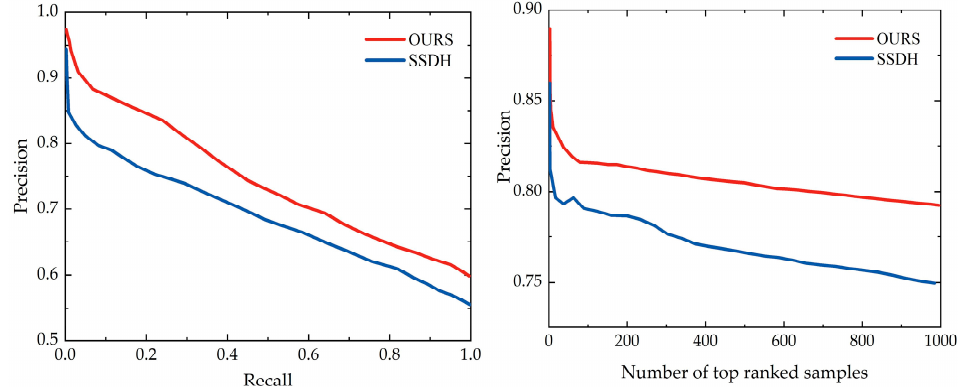
Figure 11. mAP on Visual Map.